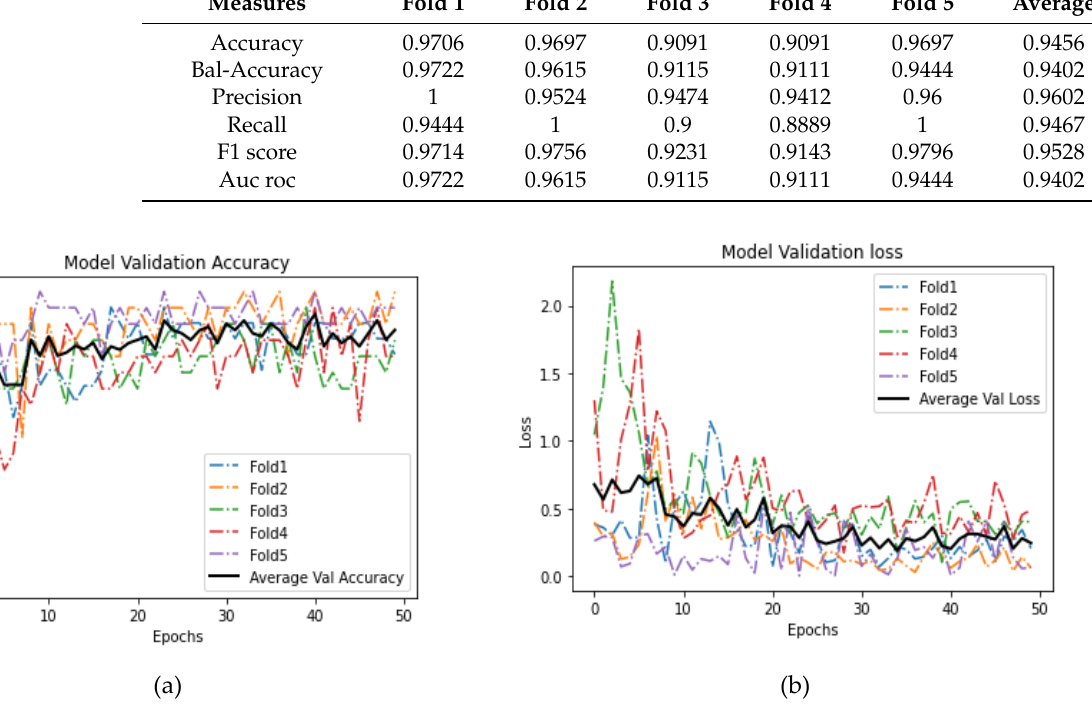
Figure 2. Validation accuracy and loss curve for MobileNet. ( a ) Model Validation Accuracy; ( b ) Model Validation Loss.